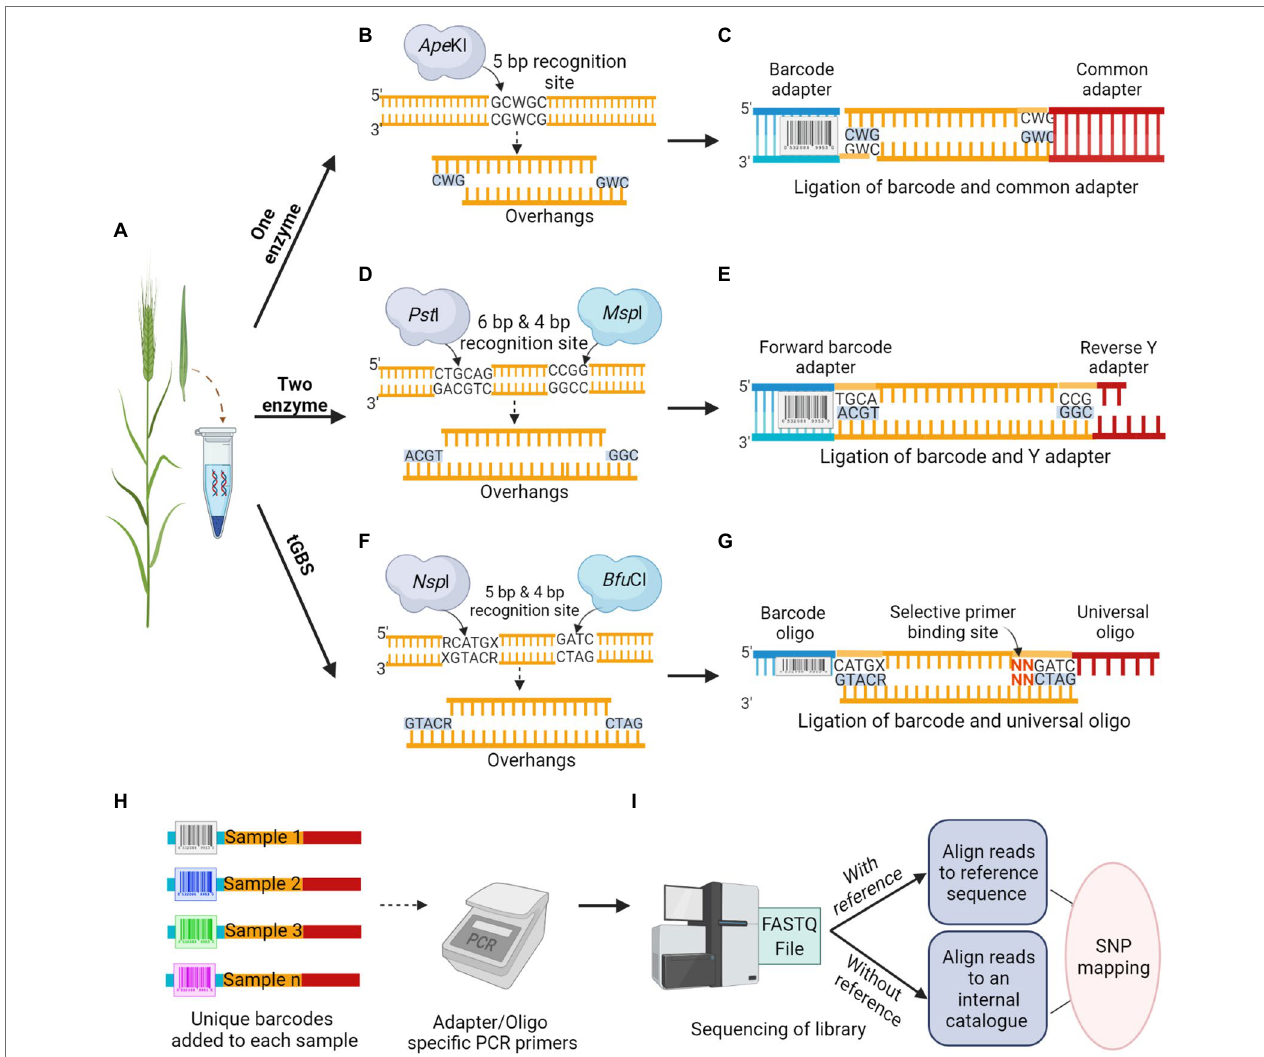
FIGURE 2 | Schematic overview of Restriction Enzyme based GBS methodology. (A) Tissue sample collection is followed by DNA isolation from the crop. (B,D,F) DNA digestion by; One enzyme, Ape KI, that makes a cut to produce overhangs (B) , classical Two enzyme, a rare cutter Pst I and a common cutter Msp I produces overhangs (D) , and new version of Two enzyme called tGBS, using a different set of restriction enzymes, Nsp I and Bfu CI capable of better digestion produces overhangs in opposite directions (F) . (C,E,G) Adapter ligation to the digested sample; One enzyme, ligation of barcode and common adapter (C) , classical Two enzyme, ligation of forward barcode and reverse Y adapter (E) , tGBS, ligation of barcode and universal oligo. Nucleotide sequence in red possesses the matching bases in selective primer for target specificity (G) . (H) Multiplexing; a unique barcode used for each accession allows the pooling of DNA samples before the amplification step. (I) The mixed libraries, uniquely barcoded, and amplified samples will be run in a next-generation sequencer. The sequence reads will be analyzed in various bioinformatic pipelines based on the availability of reference